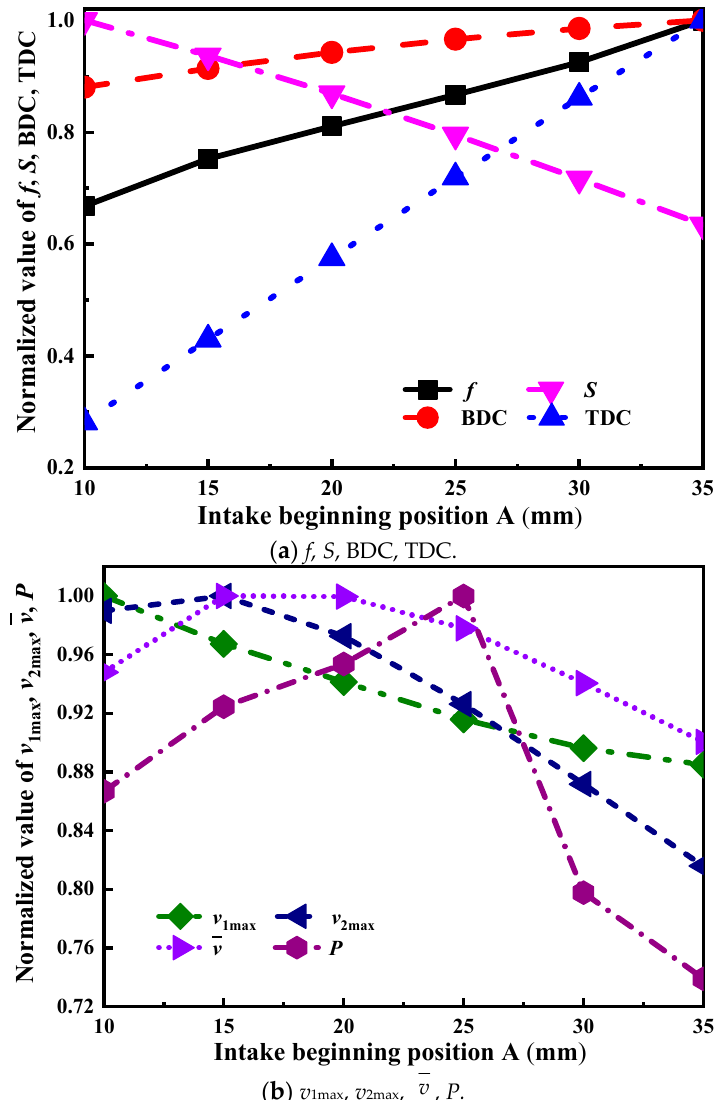
Figure 11. Variation of performance parameters with intake beginning position A.